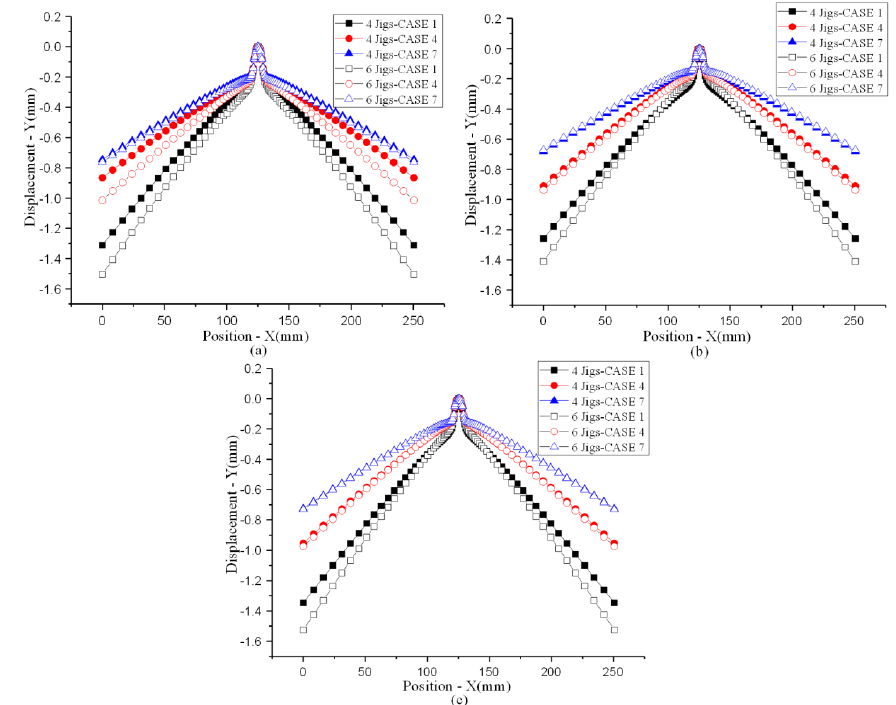
Figure 15. Y-deformation using an applied jig fixture with a depressed displacement of 0 mm: ( a ) line 1; ( b ) line 2; ( c ) line 3.